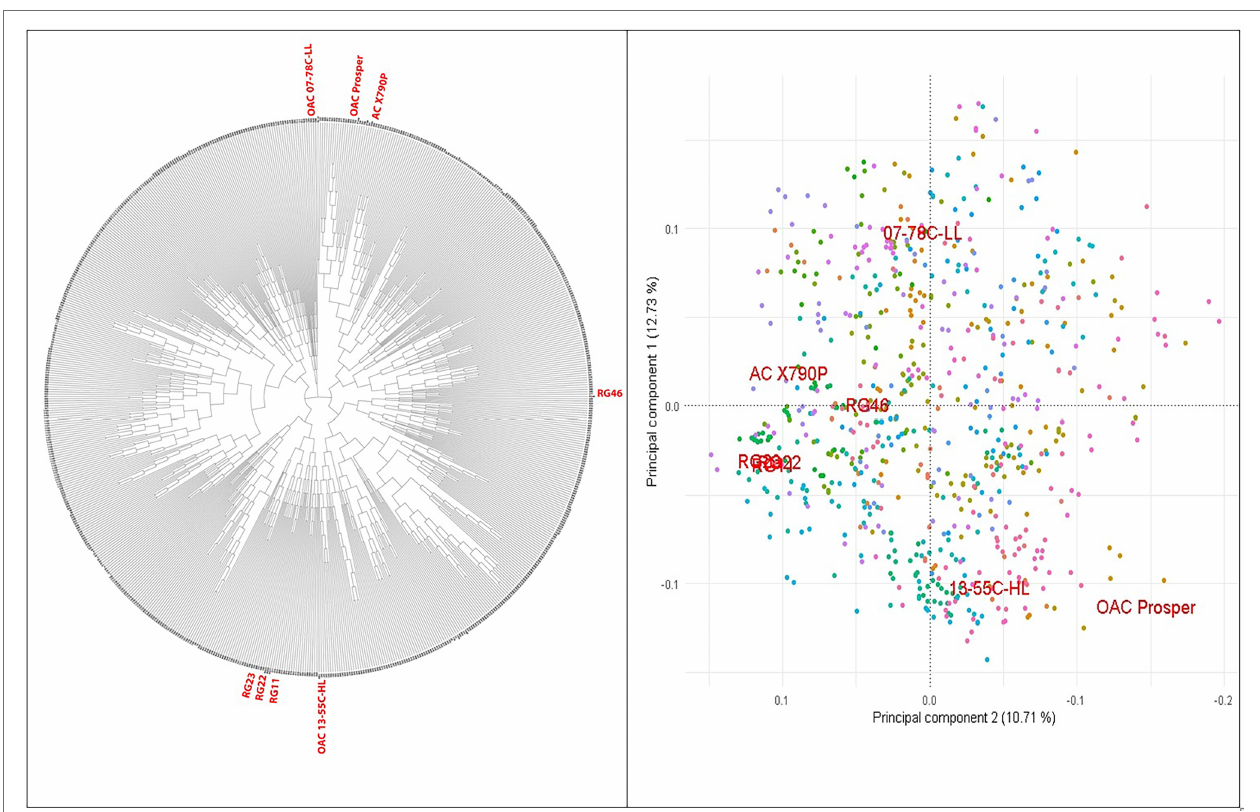
FIGURE 2 | PCA and phylogenetic relationships of the 716 SoyMAGIC RILs and eight parental lines (in red) based on 122747 SNP markers.